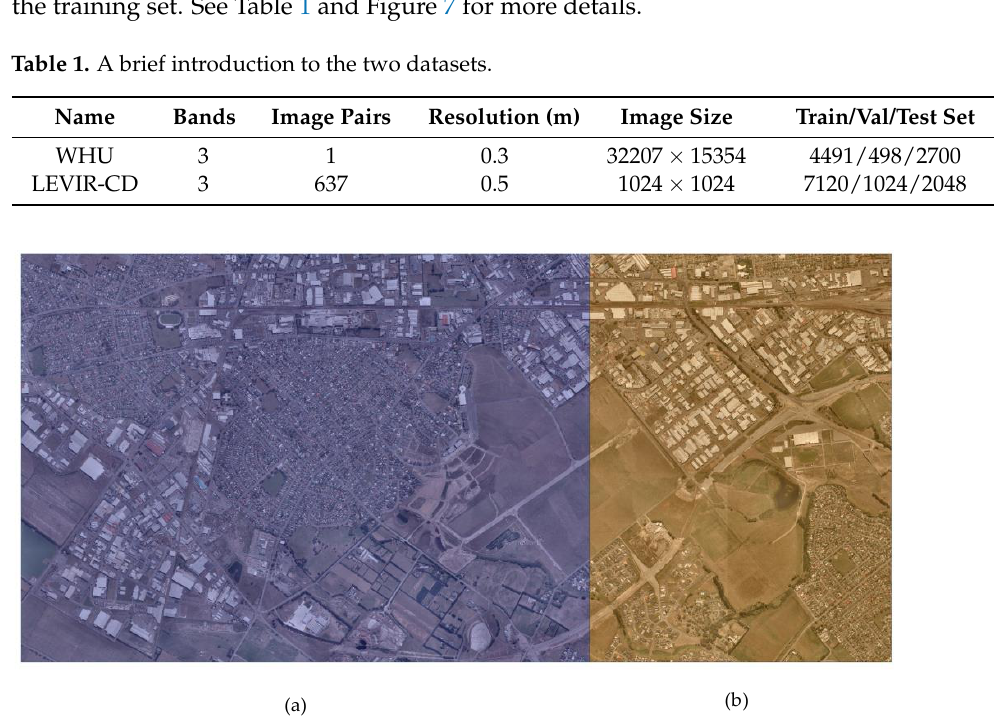
Figure 7. WHU train/validate/test dataset for the year 2012. ( a ) Train and Val set. ( b ) Test set.